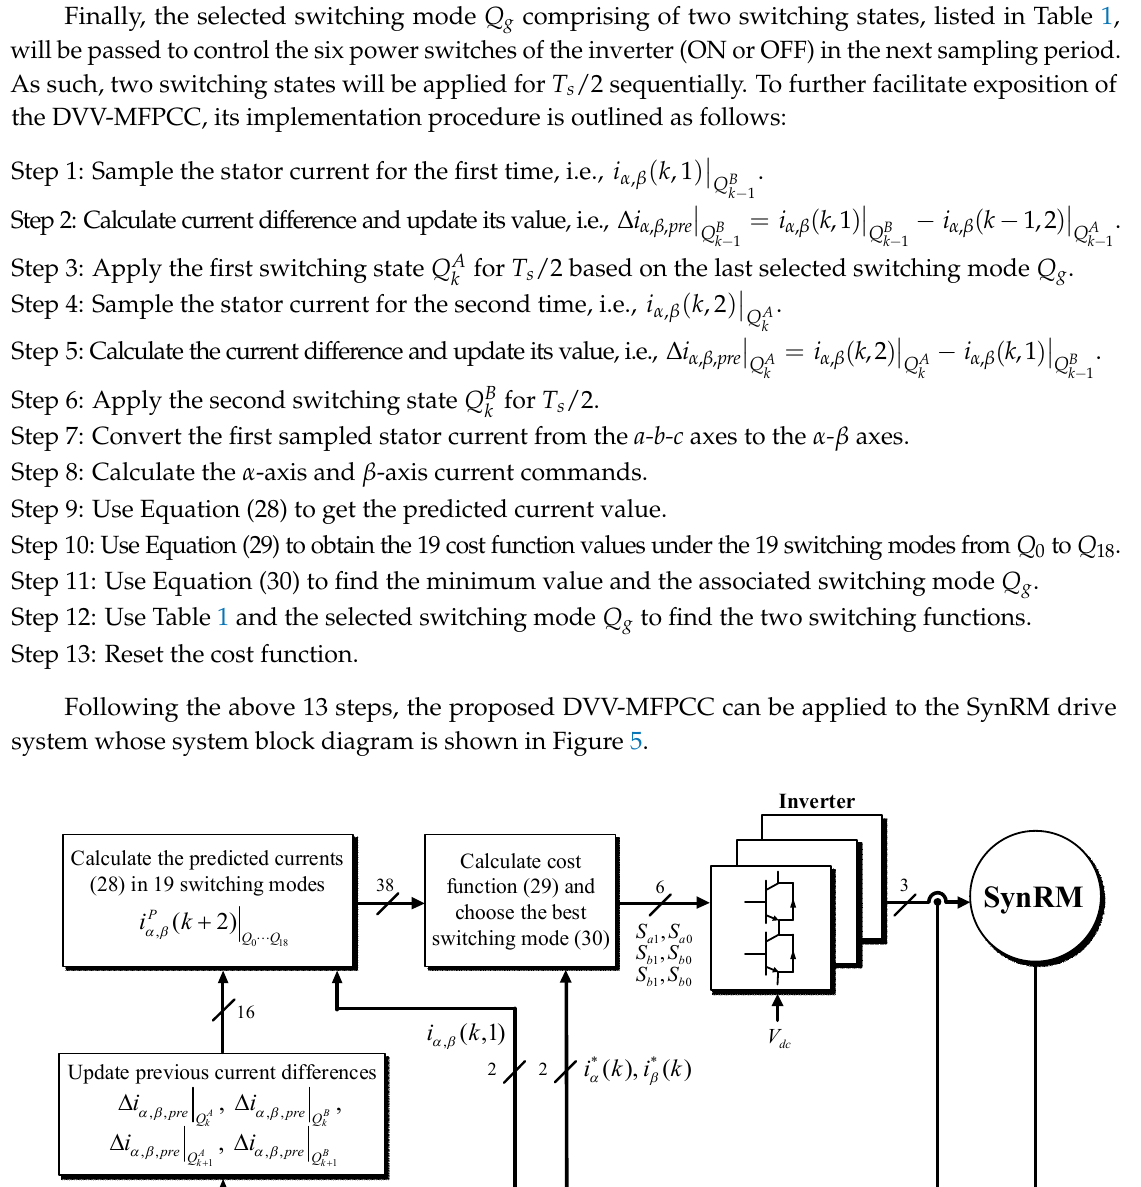
Table 2. The overall system consists of 9 parts: (A) DSP TMS320F28377S, (B) intelligent power module inverter, (C) two current sensors, (D) current/voltage conversion circuit, (E) 16-bit